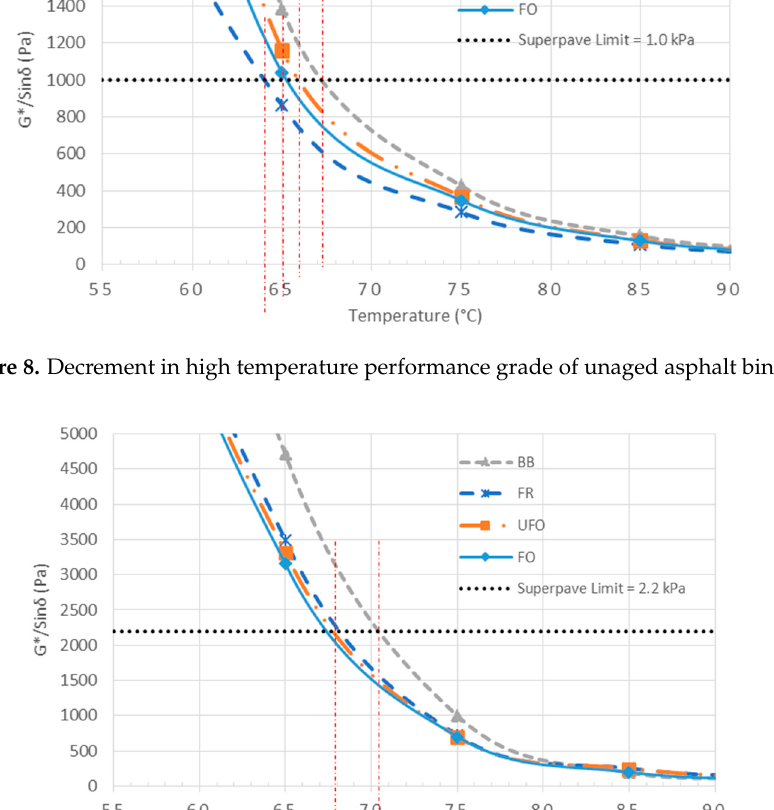
Figure 9. Decrement in high temperature performance grade after RTFO aging.